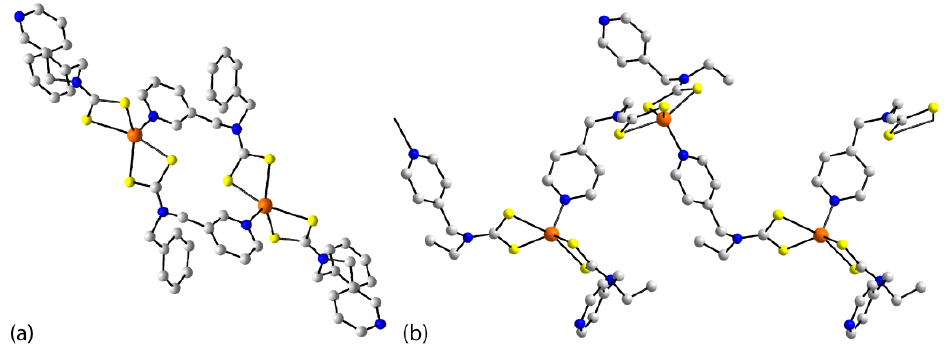
Figure 6. ( a ) The centrosymmetric, dimeric aggregate formed by [Zn(L 1 ) 2 ] 2 in ( 22 ) and ( b ) supramolecular chain formed by [Zn(L 14 ) 2 ] n . in the crystal of 24 .